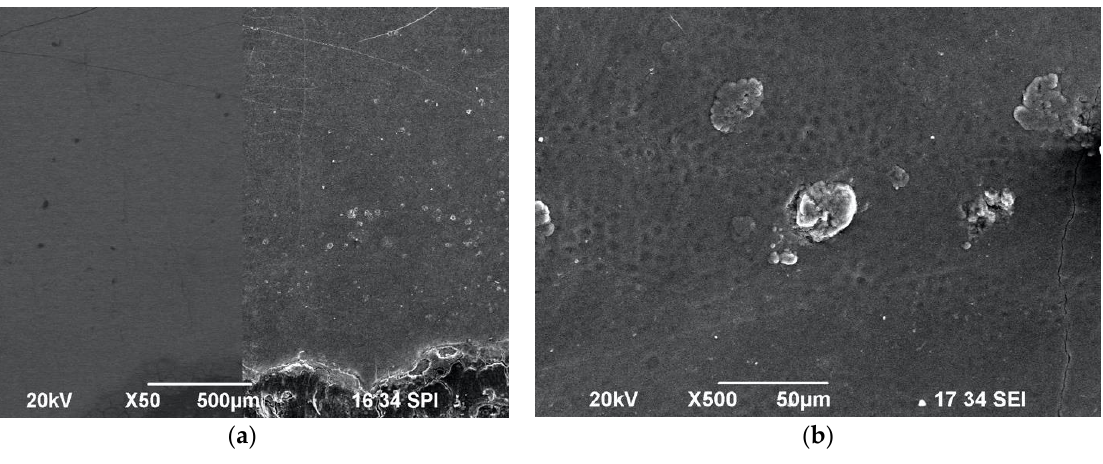
Figure 5. SEM images of enamel surface morphology following irradiation with 0.75 W/15 Hz/50 mJ/12 J/cm 2 with maximum water spray cooling—Group E—under ×50 magnification ( a ) and ×500 magnification ( b ), showing presence of scattered impact craters.